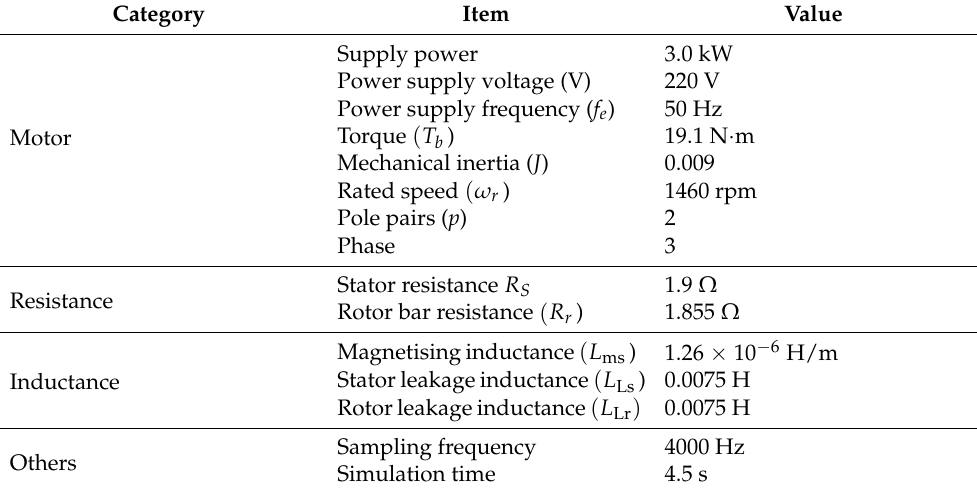
Table 1. Parameters used in simulations with IM.